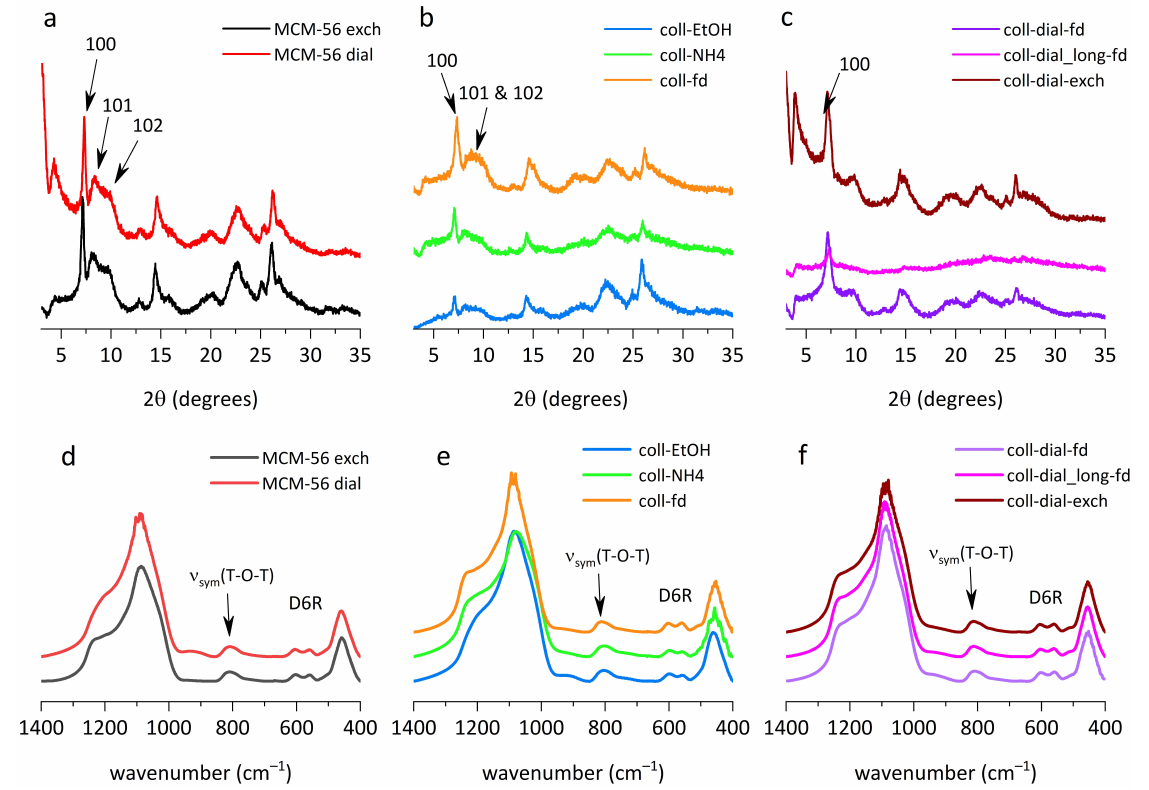
Figure 1. X-ray diffraction patterns and infrared (IR) spectra in KBr technique for the zeolites under study: ( a , d ) MCM-56 as synthesized and dialyzed, ( b , e ) colloids precipitated with ethanol, ammonium nitrate and freeze-drying (lyophilization), ( c , f ) colloids purified by dialysis and subsequently precipitated. All samples were additionally calcined before IR and XRD